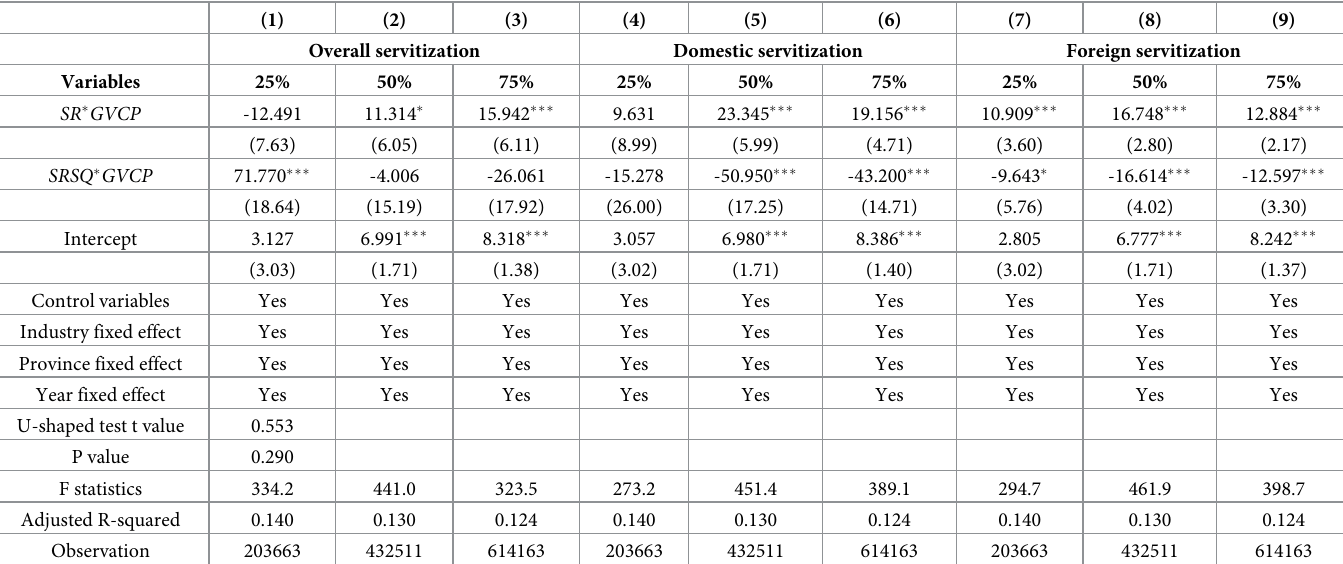
Table 10. The results of the moderating effect of GVC participation on the impact